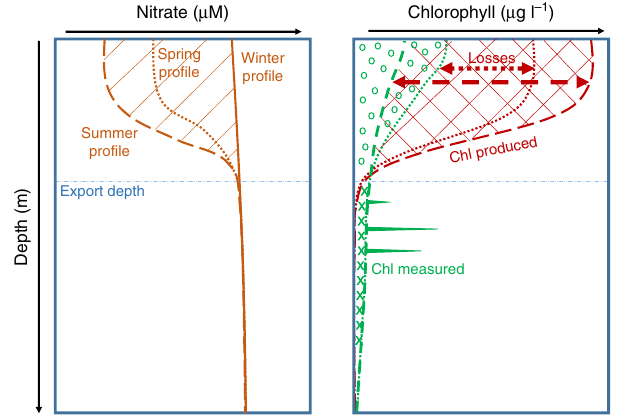
Fig. 3 Schematic of steps to determine the fate of phytoplankton. After ruling out advection by comparing the water column physical properties between consecutive pro fi les, we can compare a spring or summer nitrate pro fi le to the winter nitrate pro fi le (left panel). Second, based on the observed nitrate depletion (the hatched area in the left panel), we can calculate the chlorophyll produced (right panel, dotted lines correspond to spring in the both panel, dashed lines to summer). Third, by comparing the chlorophyll produced to the chlorophyll measured, we get the cumulative loss terms (red arrows in the right panel). Loss terms associated with different parts of the water column. Below the export depth, the excess chlorophyll reveals the export of phytodetritus, whereas herbivory mainly takes place between the surface and the export depth. The accumulation of phytoplankton biomass takes place between the surface and the export